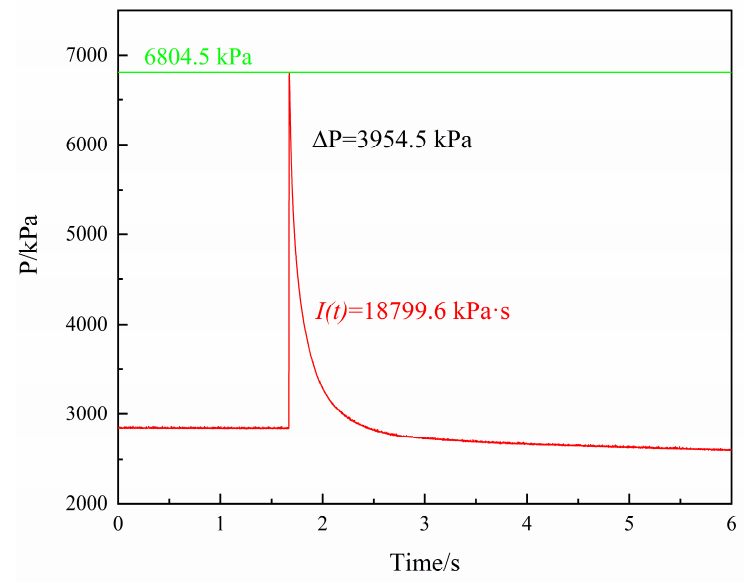
Figure 6. P – t profiles of samples at a constant volume of 330 mL .